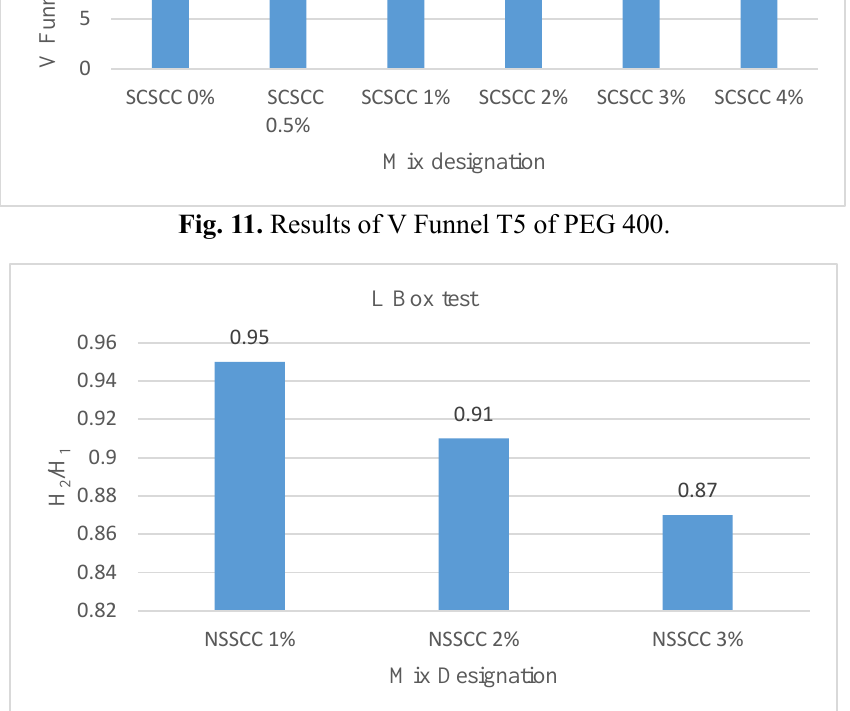
Fig. 12. Results of L Box test for Nano Silica.